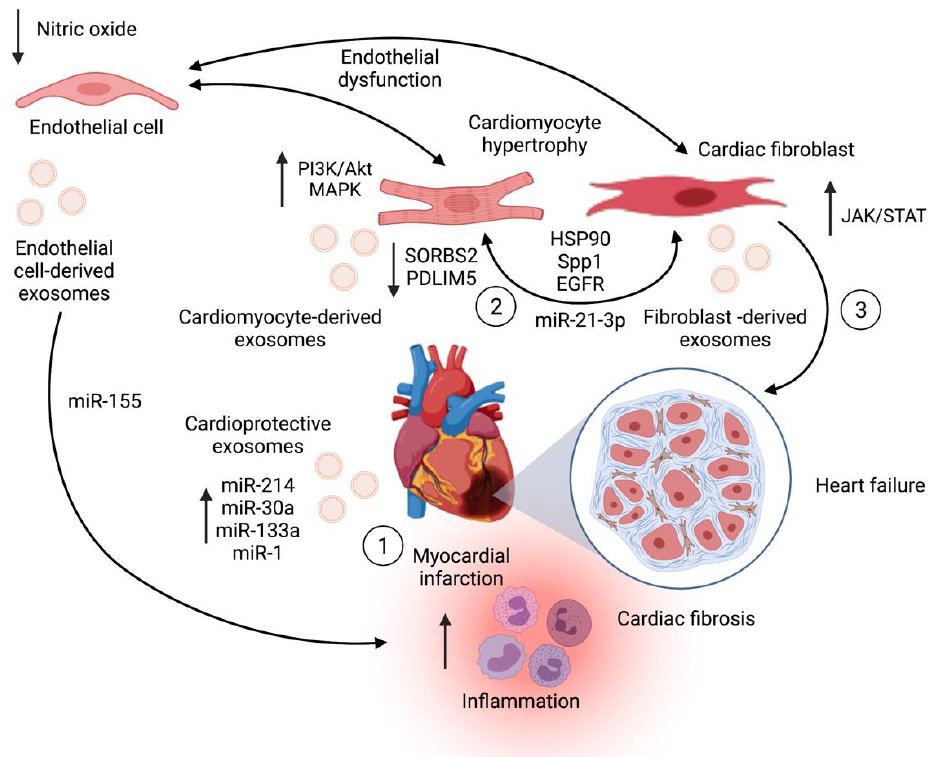
Figure 4. Cardiomyocyte-derived exosomes can either ameliorate or worsen myocardial injury dur- ing ischemia. (1) In the onset of myocardial infarction, cardiomyocyte-derived exosomes release ex- osomes enriched in miRNAs with a cardioprotective function. However, during heart failure, these cells release exosomes that increase cardiac hypertrophy and fibrosis. (2) In this setting, cardiomy- ocyte-derived and cardiac fibroblast-derived exosomes transport proteins and miRNAs that target critical signaling pathways in cardiomyocyte hypertrophy and fibroblast activation. (3) Cardiomy- ocyte-derived and cardiac fibroblast-derived exosomes contribute to collagen deposition and car- diac remodeling in heart failure. Endothelial dysfunction is mediated partly by endothelial cell-de- rived exosomes that promote inflammation and cardiac dysfunction in this context.